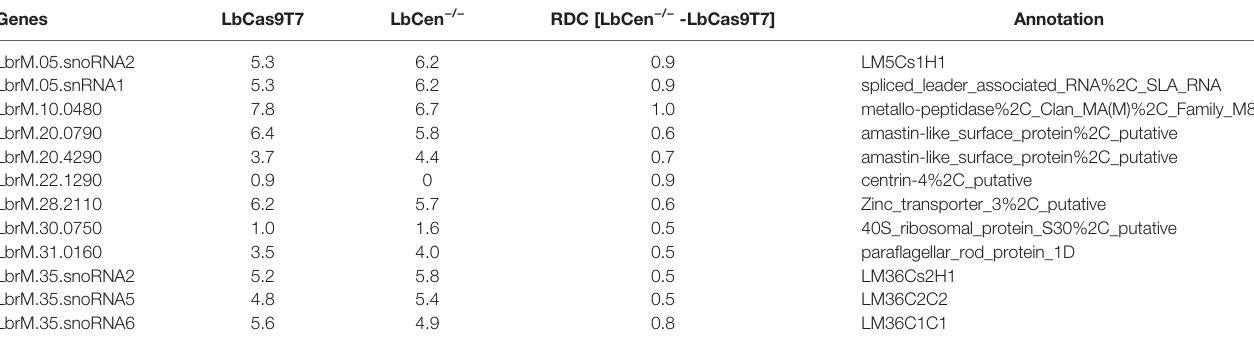
TABLE 1 | RDC differences between LbCas9T7 - LbCen − / − . For a total of 12 genes, LbCas9 – LbCen − / − RDC difference is higher than 0.5. From these, eleven correspond to multigene families or structural RNAs, and only one, the centrin LbrM.22.1290 gene, has the expected read depth coverage of a single copy gene in LbCas9 line, with RDC value of zero for LbCen − / −